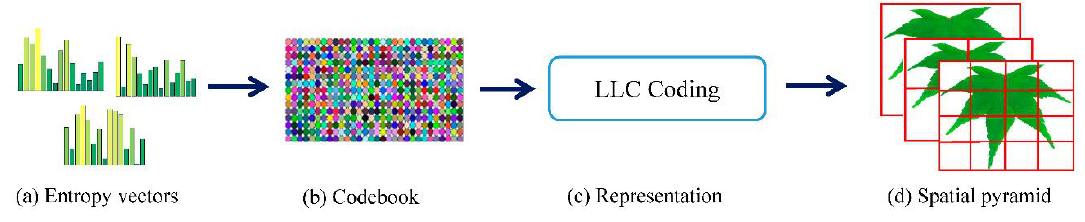
Figure 5. Acquisition of image features using BOF_DPCNN: ( a ) entropy vectors obtained by DPCNN model; ( b ) codebook obtained by learning features; ( c ) the LLC coding; and ( d ) SPM for pooling.